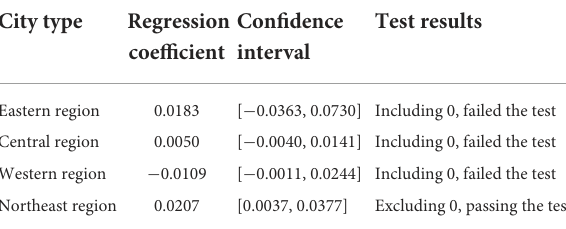
TABLE 7 The bootstrap test results.